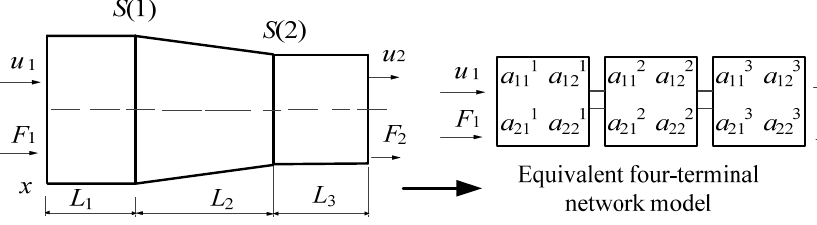
Figure 4. Equivalent four-terminal network of amplitude horn.